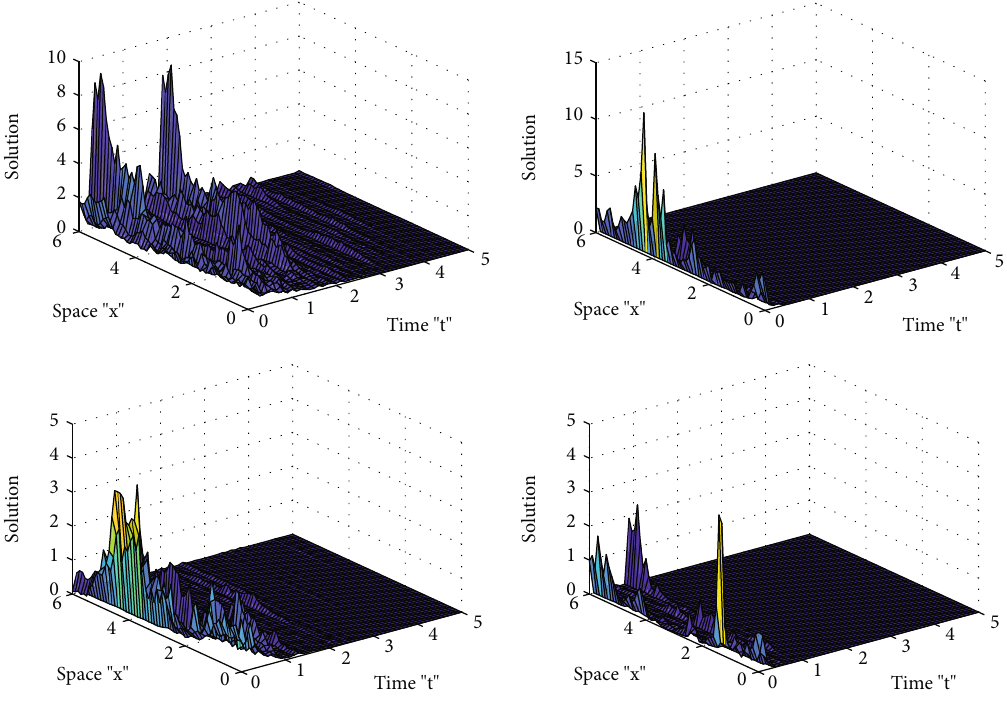
Figure 2: 3D plot of Equations (28) and (29) with σ = 1, 2 and α = 1 .